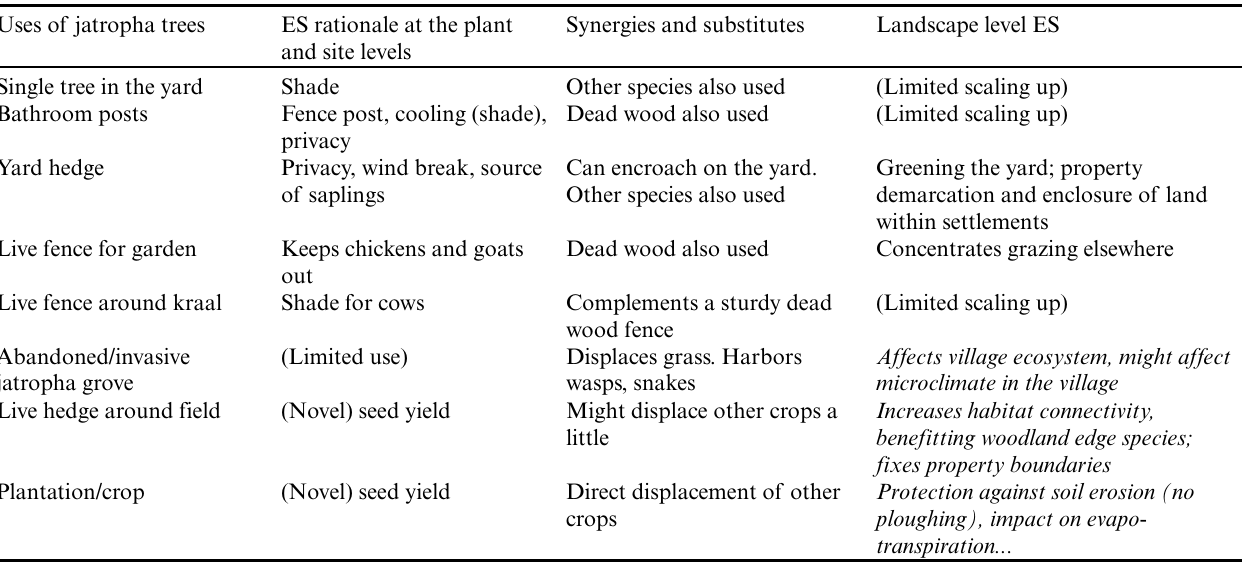
Table 3 . Uses of (whole) jatropha trees, and the key ecosystem services (ES) associated with these plants at the site and the landscape levels. (normal text is from field observations, text in italics is hypothetical/from the